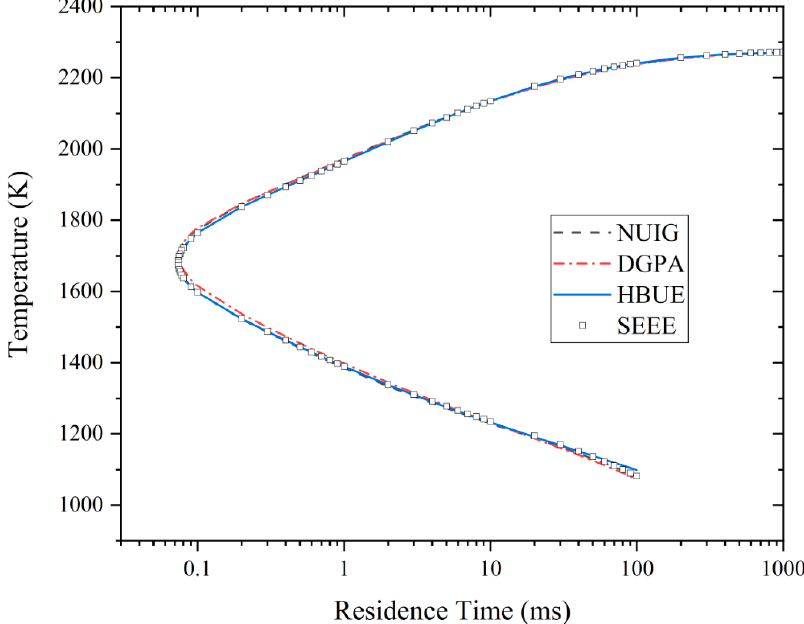
Figure 14. Comparison of C-curves between NUIG, DGPA, HBUE, and SEEE at an equivalence ratio of 1.0 and an initial temperature of 298 K.